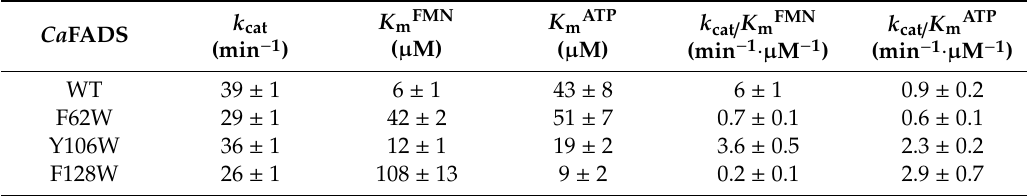
Table 1. Steady-state kinetic parameters for the FMNAT activity of Ca FADS variants. Parameters